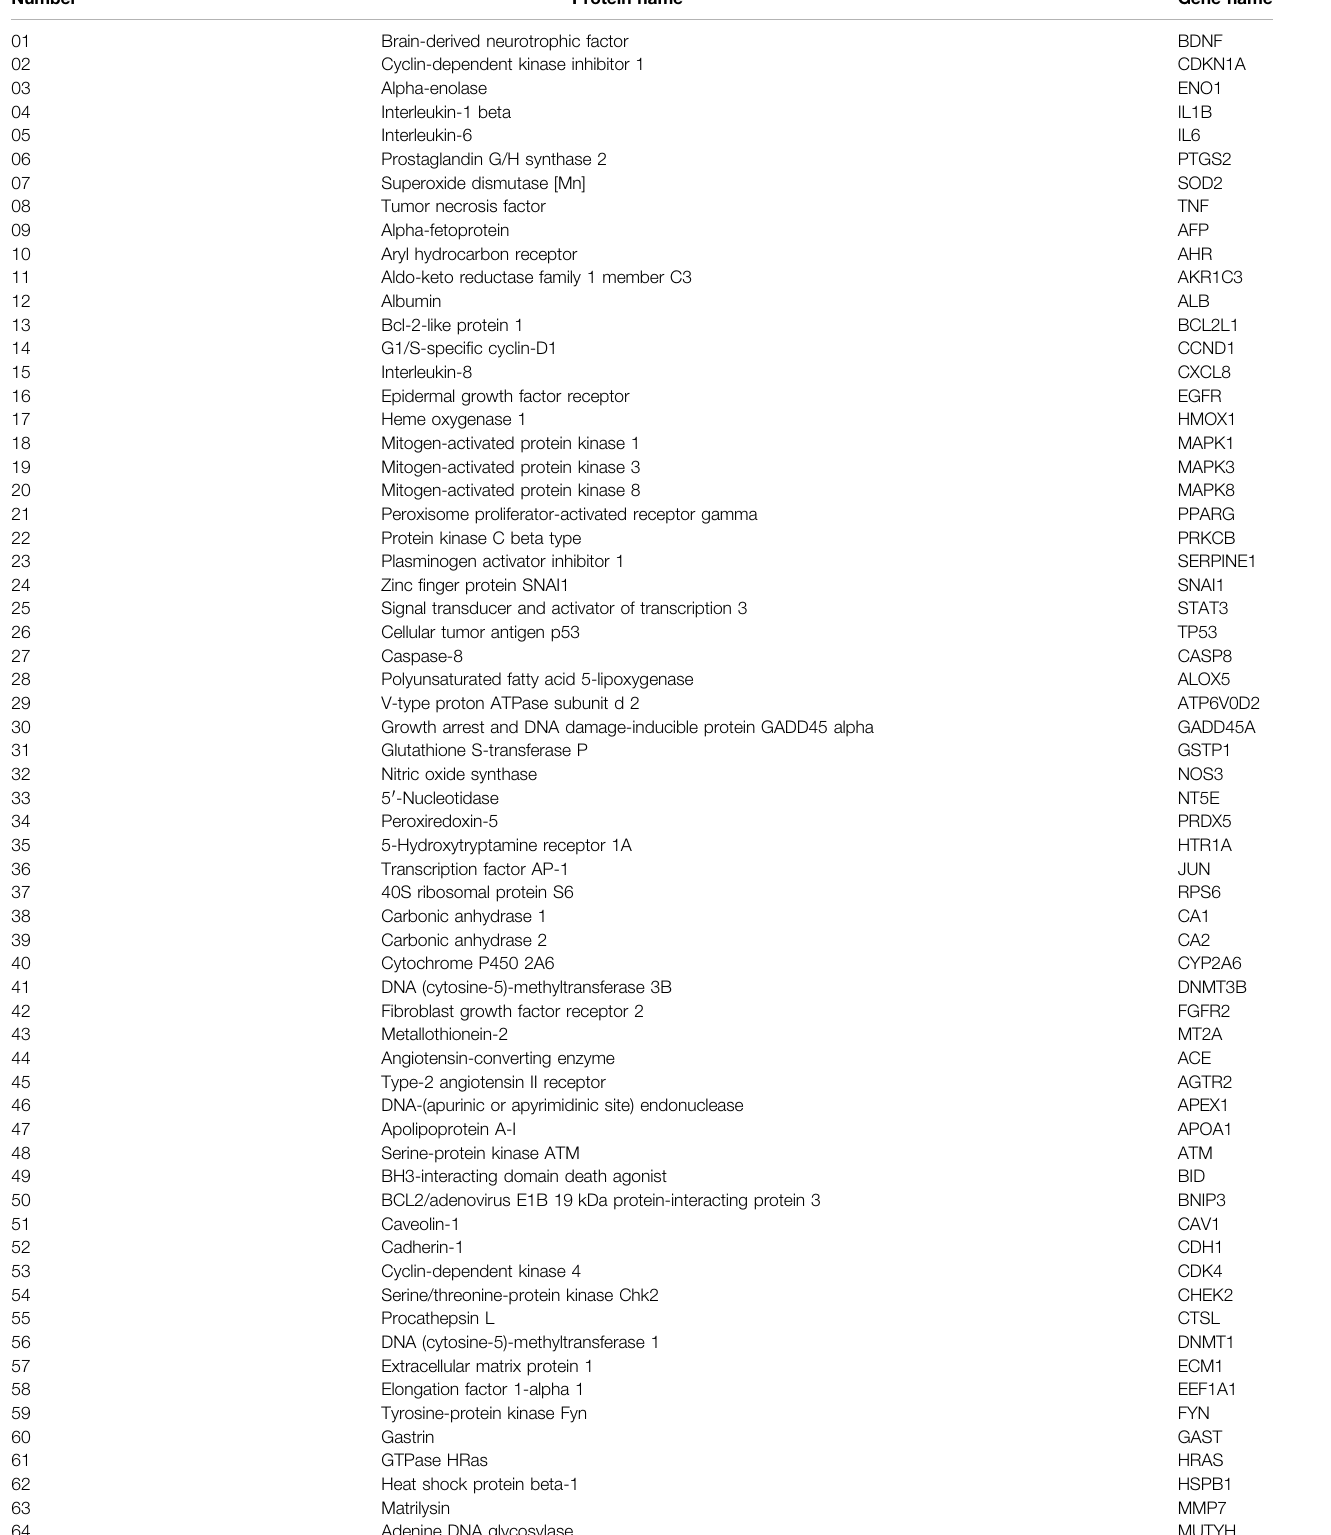
TABLE 2 | Gastric cancer-related targets of D. of fi cinale extract.